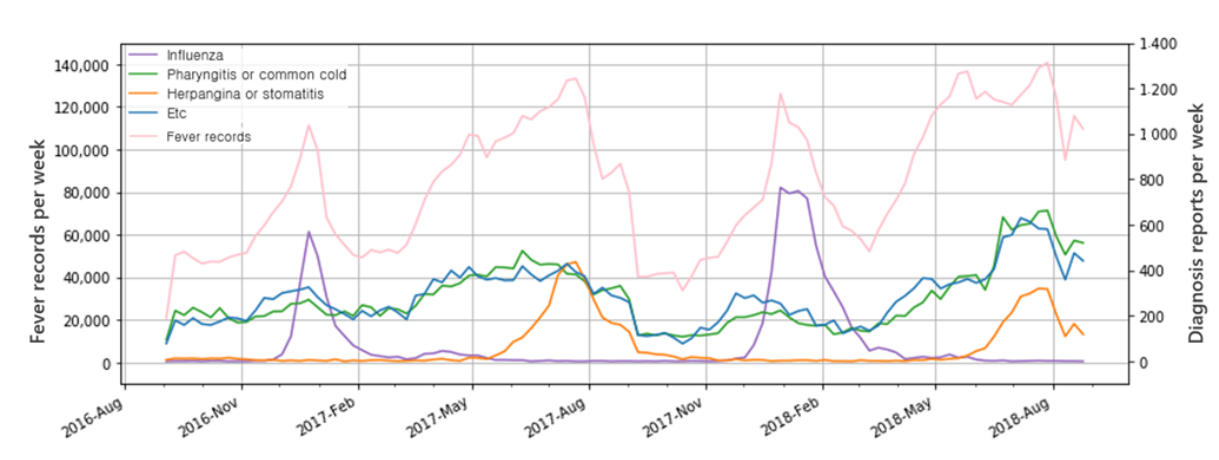
Figure 2. Change of diagnosis submissions and app user activity during the study period. Y-axis shows the number of submissions in each week. Fever records (left y-axis) was measured by the number of body temperature submissions to the app and is shown as a pink line. Number of each diagnosis categories (right y-axis) is shown with different colors. Pharyngitis or common cold (green line) shows the sum of pharyngitis ortonsillitis and common cold, and herpangina or stomatitis (orange line) shows the sum of canker sore and herpangina.